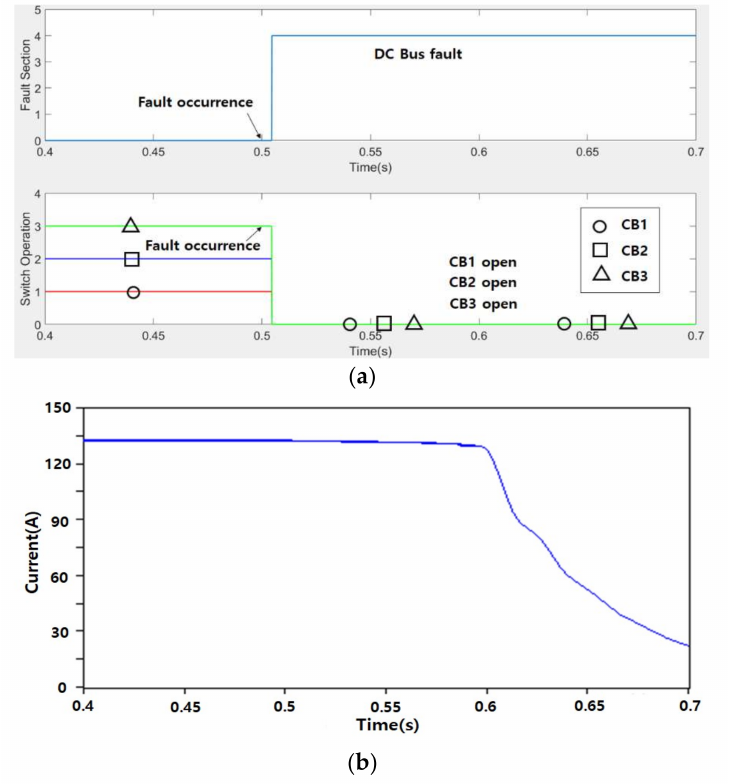
Figure 18. Simulation results of Case 6: ( a ) Fault section and CB operation and ( b ) Load